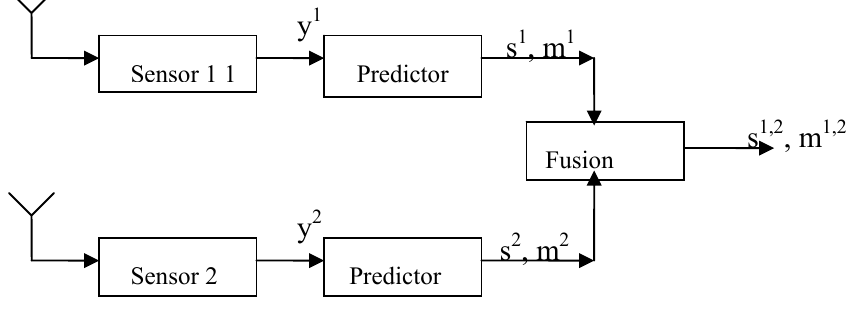
Figure 1. General diagram of Dempster-Shafer data fusion for two